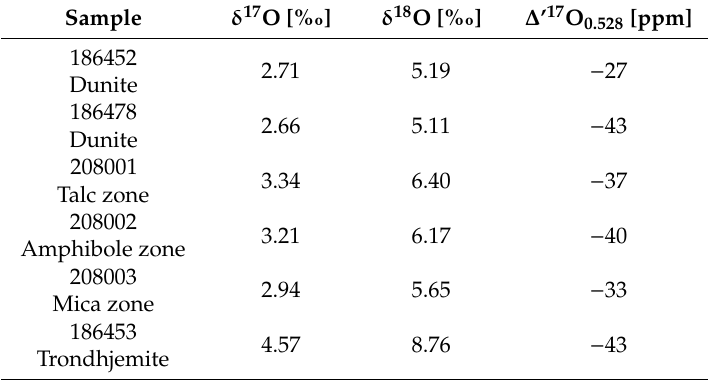
Table 6. Triple oxygen isotope compositions. Measurement precisions (1 S.D.) are ± 0.15% (cid:24) and ± 10 ppm for δ 18 O and ∆ ’ 17 O 0.528 , respectively, based on the repeated analysis of UWG-2 garnet and San Carlos